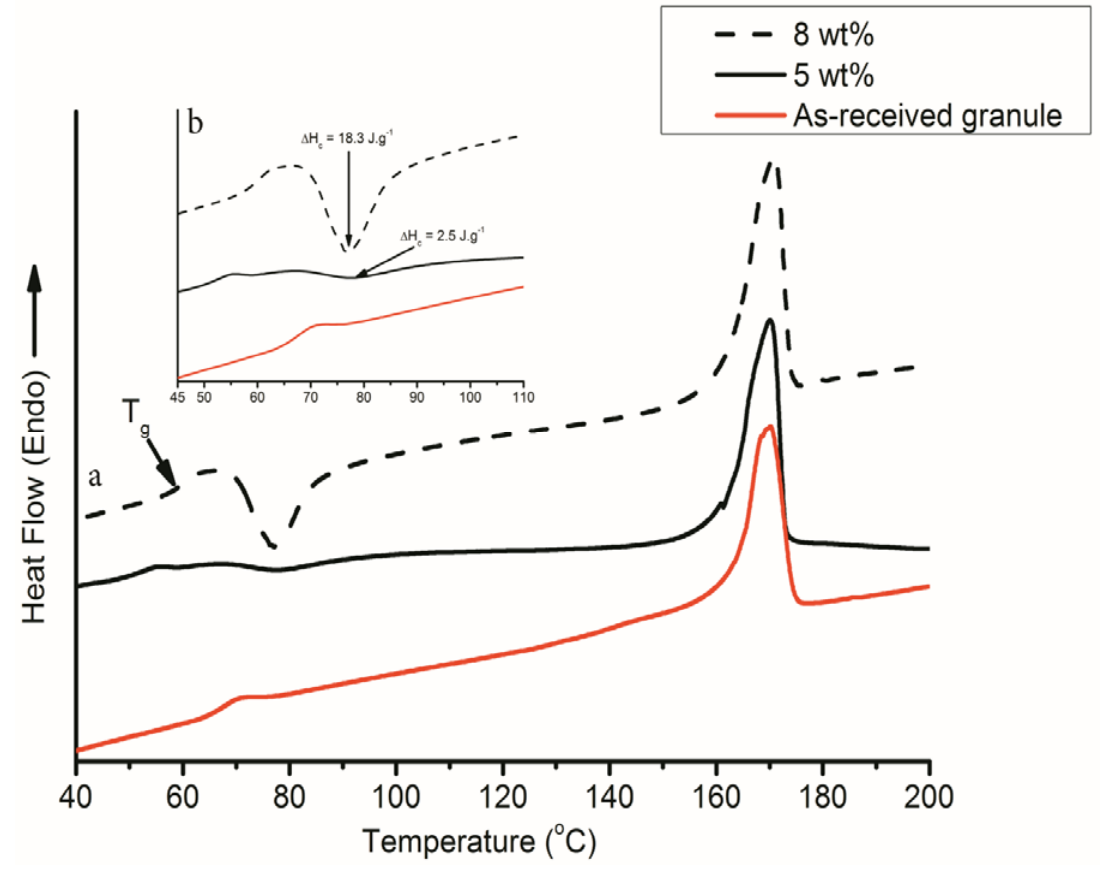
Figure 4. ( a ) DSC scans of fibers electrospun from 5 wt% and 8 wt% solutions at 15 kV and 10 cm needle tip to collector distance (NTCD); ( b ) Cold crystallization region of scans shown in